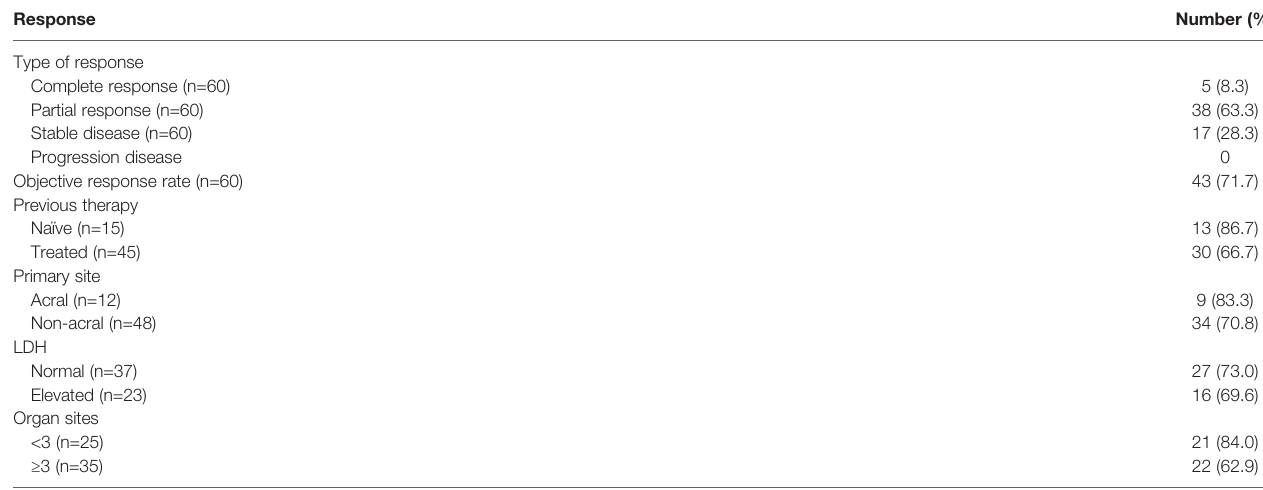
TABLE 2 | Tumor response and ORR by